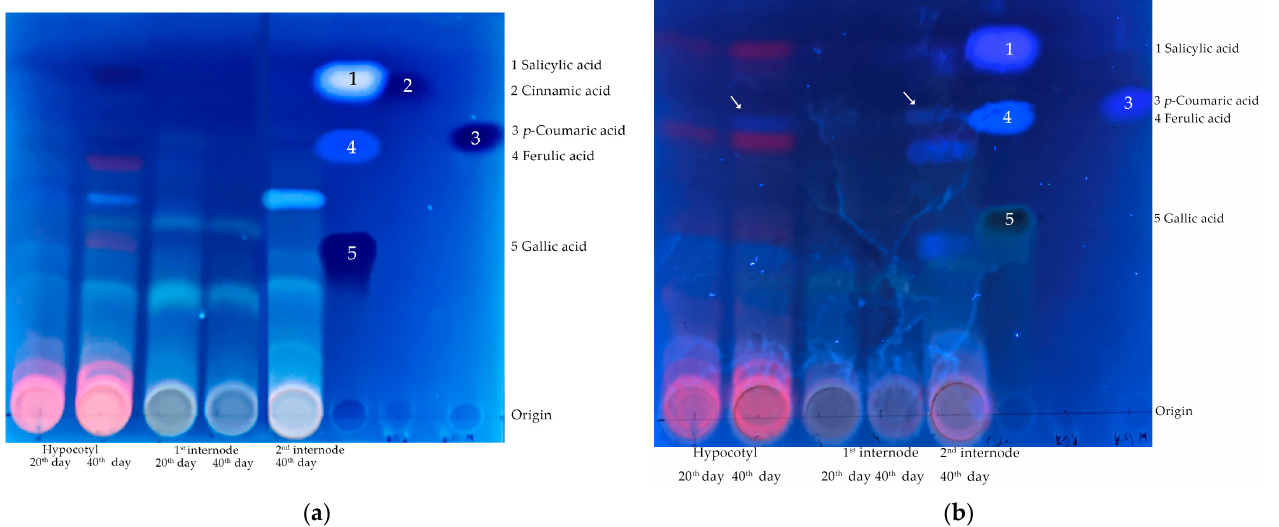
Figure 2. The spectrum of phenolic compounds in the hypocotyl, the first and second internodes of zinnia plant on the 20th and 40th days of growth: ( a ) TLC under UV 312 nm; ( b ) TLC at UV 312 nm after sodium carbonate treatment. Ferulic acid is indicated by an arrow.